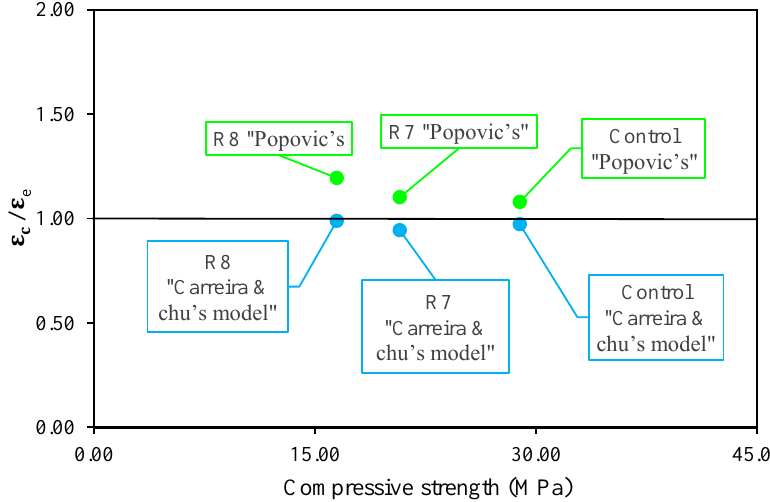
Figure 20. Comparison of measured axial strain ( ε c ) at peak stress with model predictions ( ε e ) .